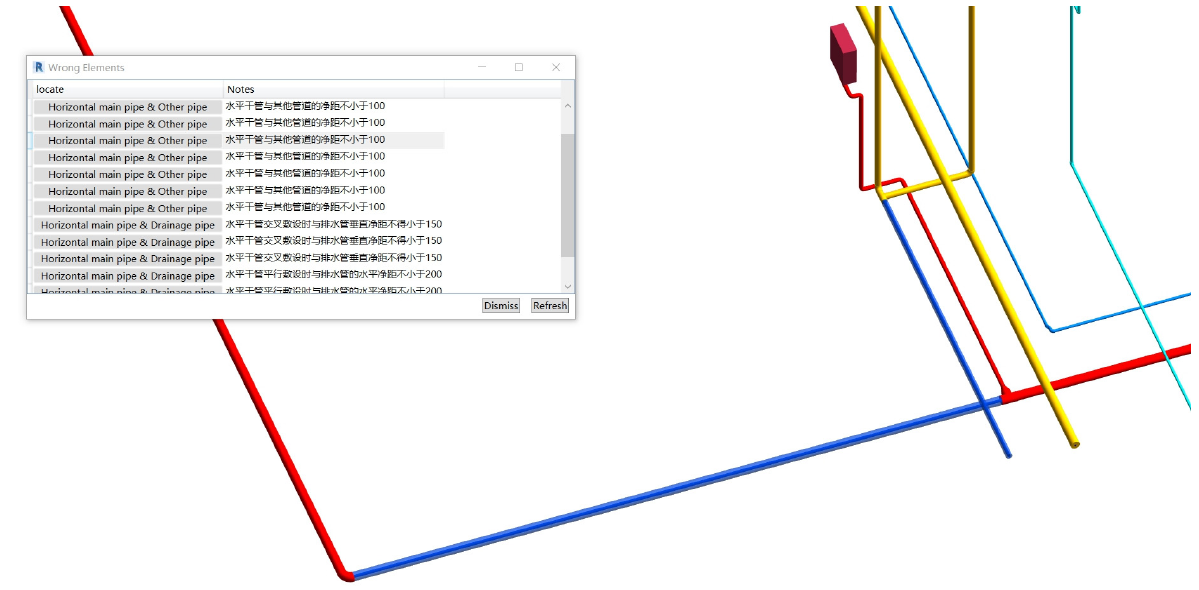
Figure 17. Checking results of the element spacing.